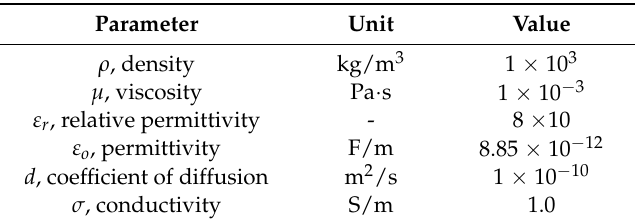
Table 1. Parameters of some variables utilized in this work.